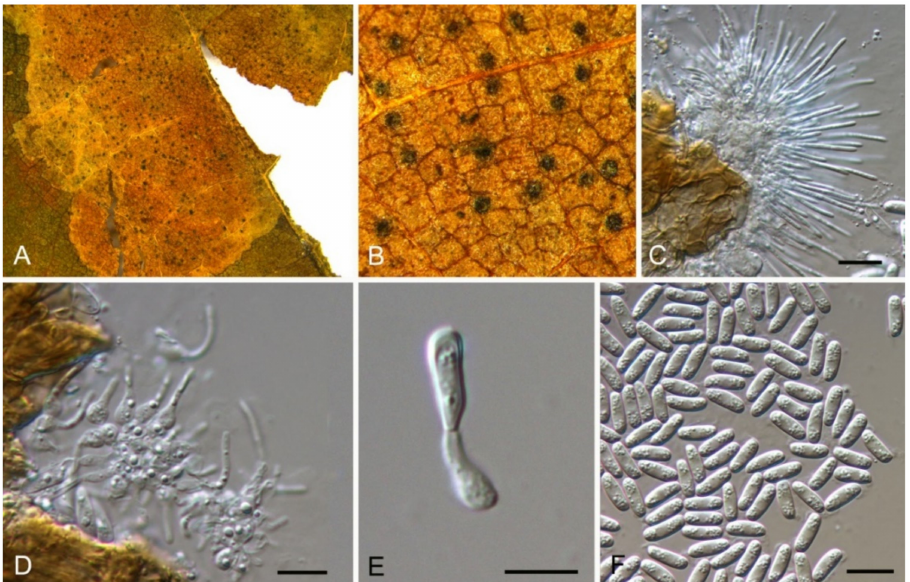
Figure 25. Pyrispora castaneae (BJFC-S1798). ( A , B ) Conidiomata on the diseased leaves of Castanea mollissima ; ( C – E ) Conidiogenous cells giving rise to conidia; ( F ) Conidia. Scale bars: ( C – F ) = 10 µ